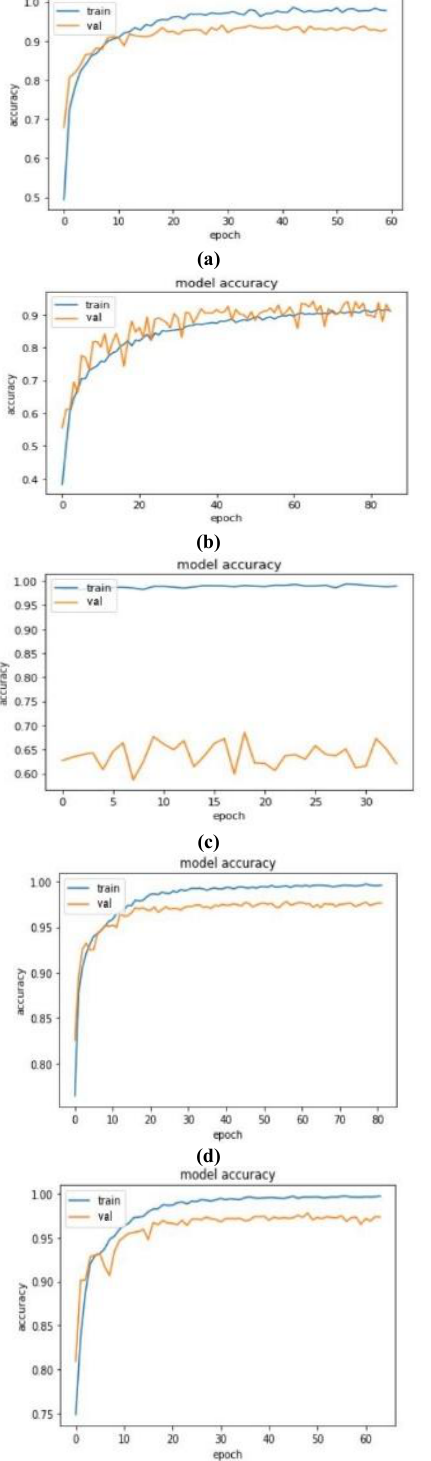
Figure 9 (a) – (e). History of Validation (in orange) & Figure 10 (a) – (e). History of Validation (in orange) & Training Accuracy (in blue) during the training of models Training Loss (in blue) during the training of models (1), (2), (5), (7) and (8), resp. for the classification of (1), (2), (5), (7) and (8), resp. for the classification of MRI scans. MRI